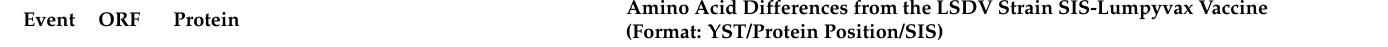
Figure 7. Gene mapping of LSDV/Thailand/Yasothon/2021. The arrows indicate transcriptional directions. The numbers represent the nucleotide positions from 1 to 150,689 bp. Each ORF is colored based on its recombination event (upper), predicted protein function, and major gene families (lower) [3]. The graphic was created using Geneious Prime ® version 2021.2.2. Light green = recombination events; Black = DNA replication and nucleotide metabolism; Red = RNA transcription and modification; Yellow = structure and assembly; Dark green = viral virulence and host range; Grey = unknown; Pink = Ankyrin repeat; Orange = Kelch-like; Purple = A52R-like. Table 3. Proteins and amino acids of LSDV/Yasothon/2021 affected by the 11 genomic recombination events as predicted by RDP4 .